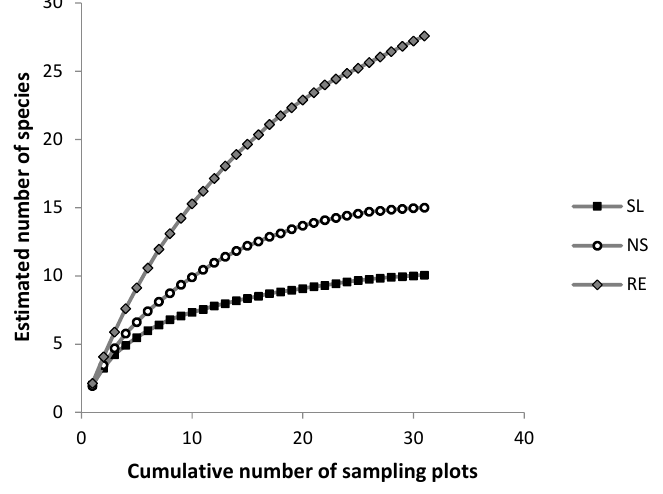
Figure B1. Estimated species richness.